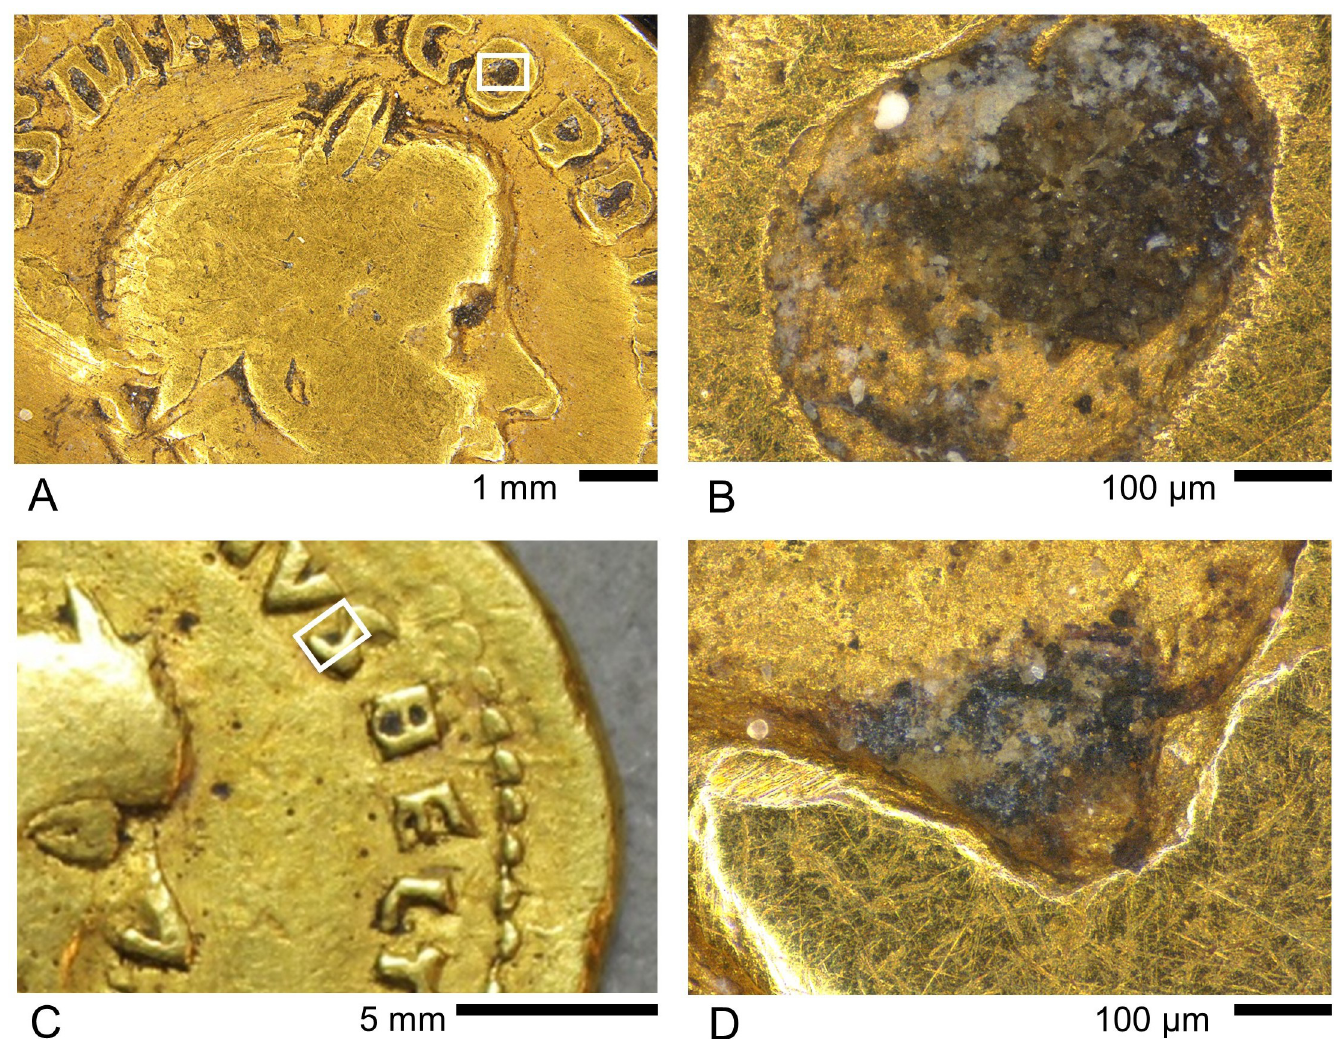
Fig 11. Appearance of larger earthen deposits on a genuine aureus and questionable medallion. A, B) Genuine Gordian III aureus GLAHM:29540; C, D) questionable Gordian III medallion GLAHM:29596.